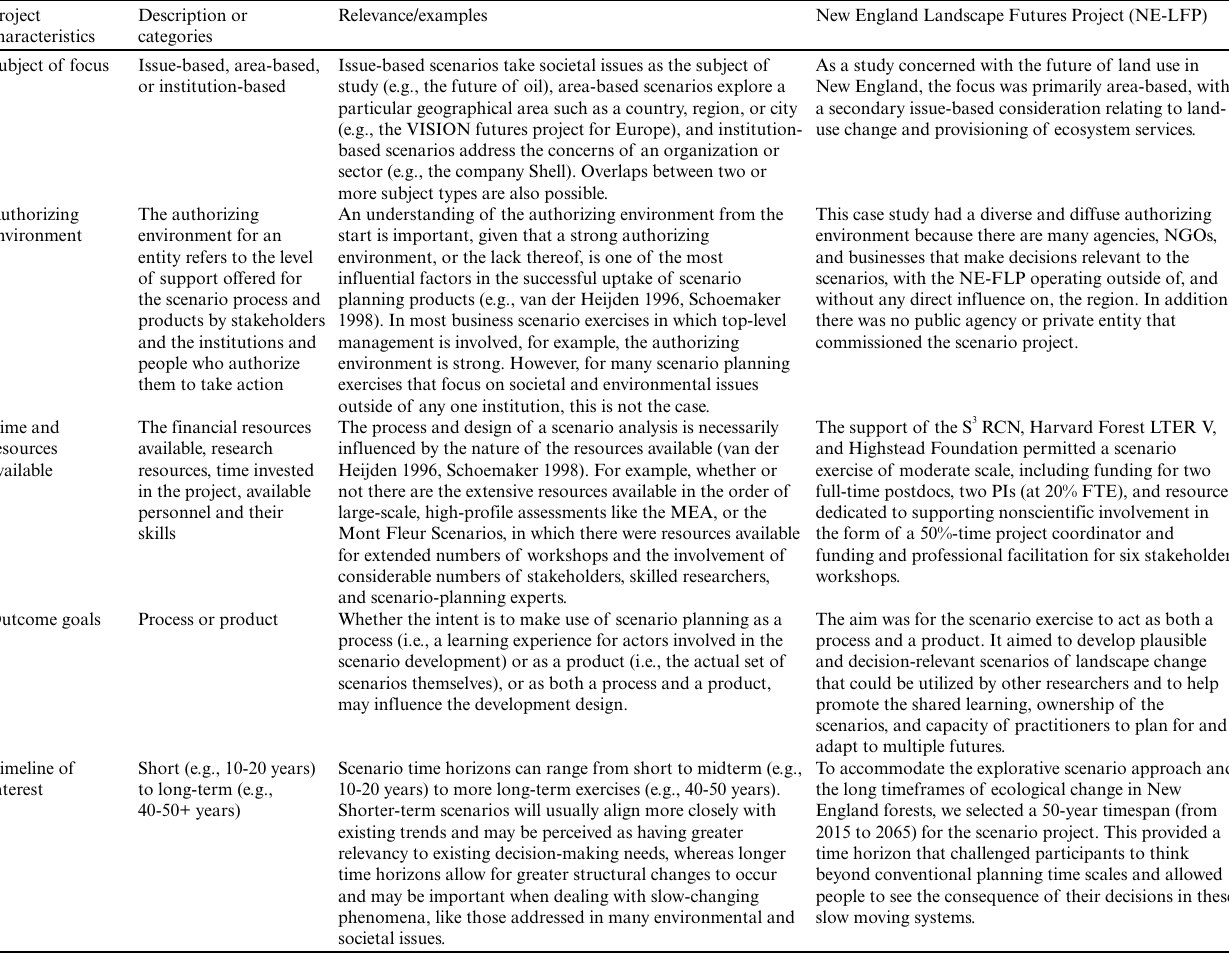
Table 1 . Characteristics of the New England Landscape Futures